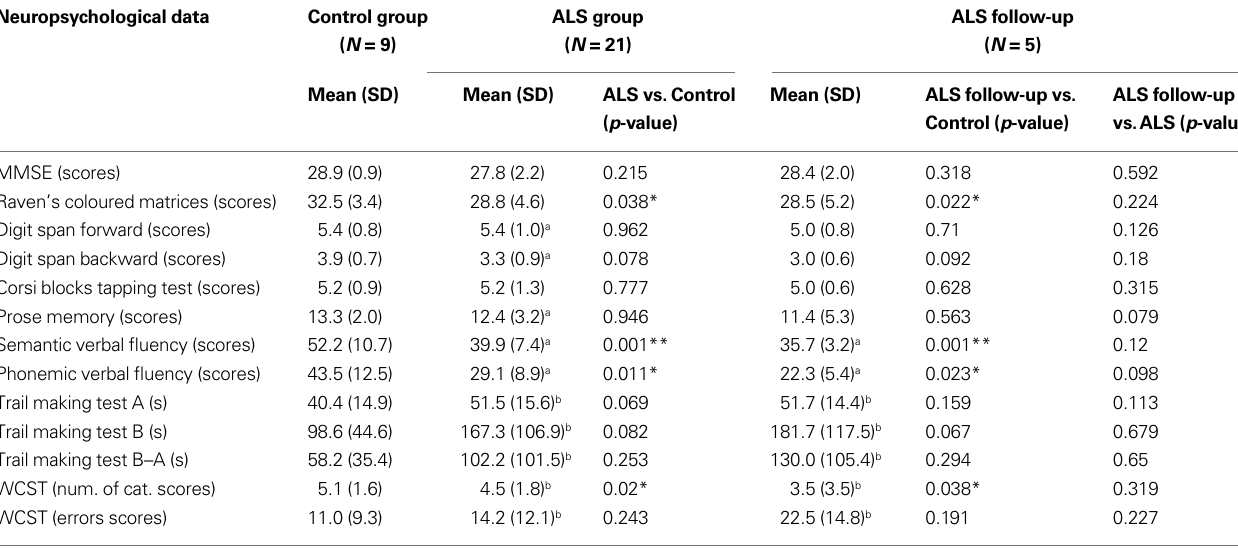
Table 3 | Neuropsychological scores in ALS and Control group; last three columns refer to the fi ve ALS patients who performed the follow-up BCI-test.